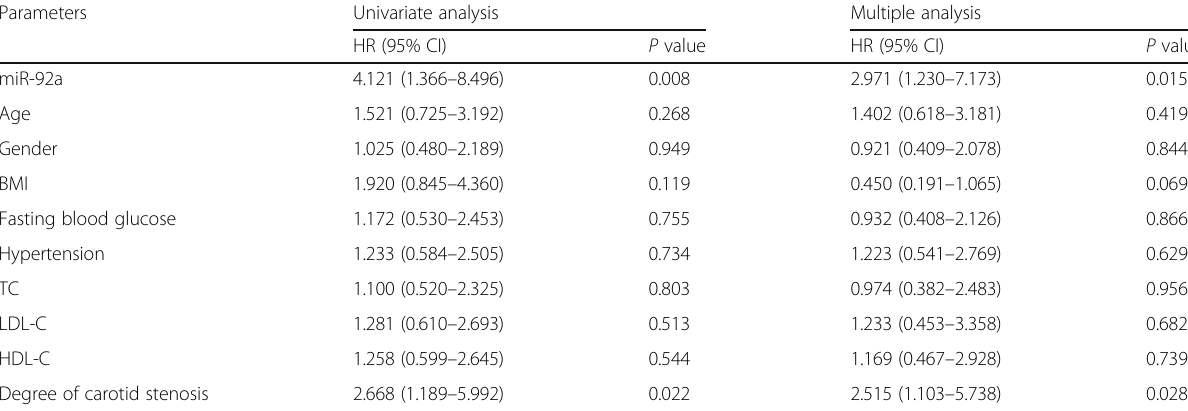
Table 3 Cox regression analysis in patients with ACSA